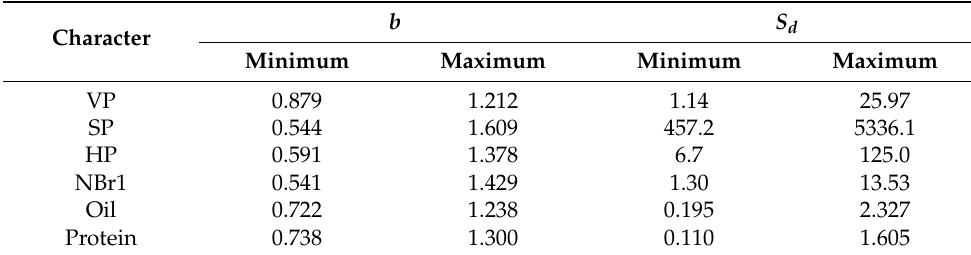
Table 4. Range of variability of stability ( b ) and plasticity ( S d )